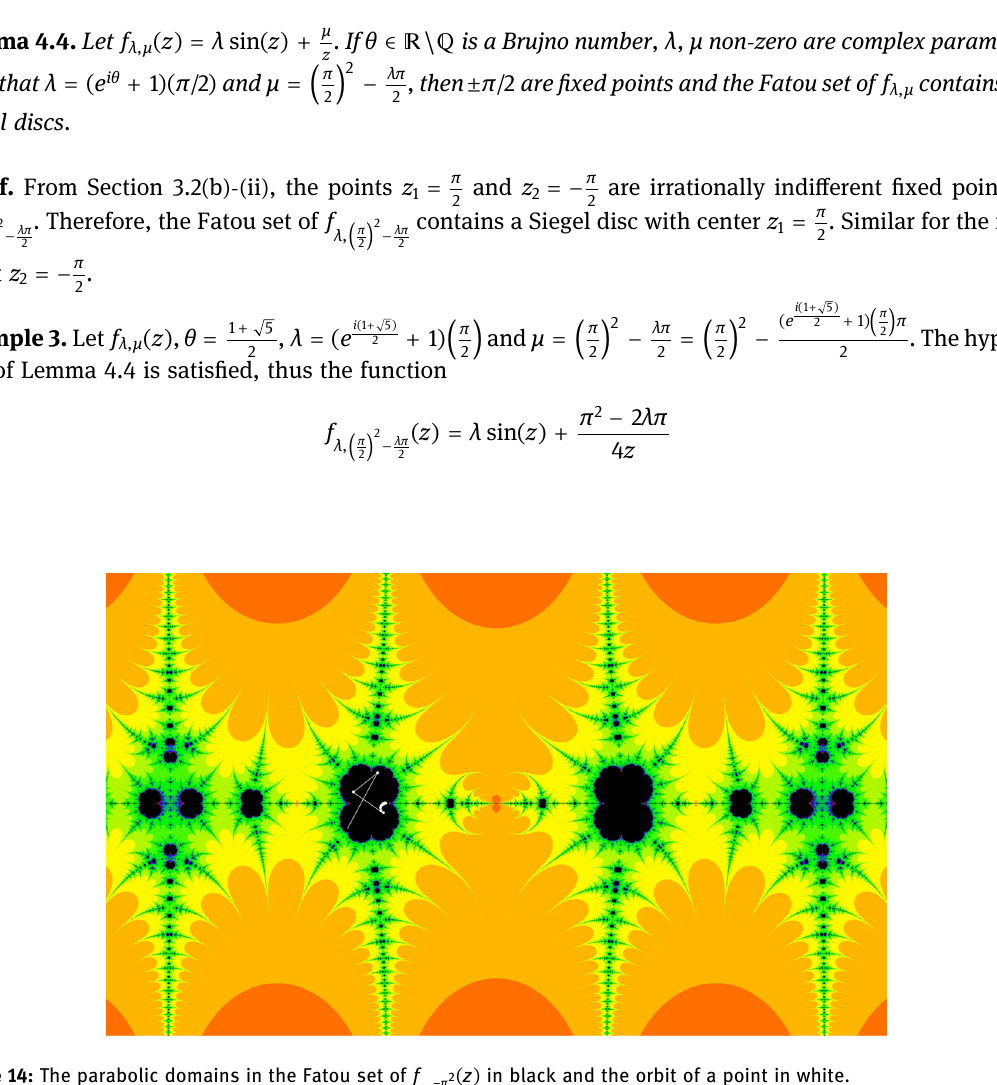
( ) in black and the orbit of a point in 2 π , π − 4